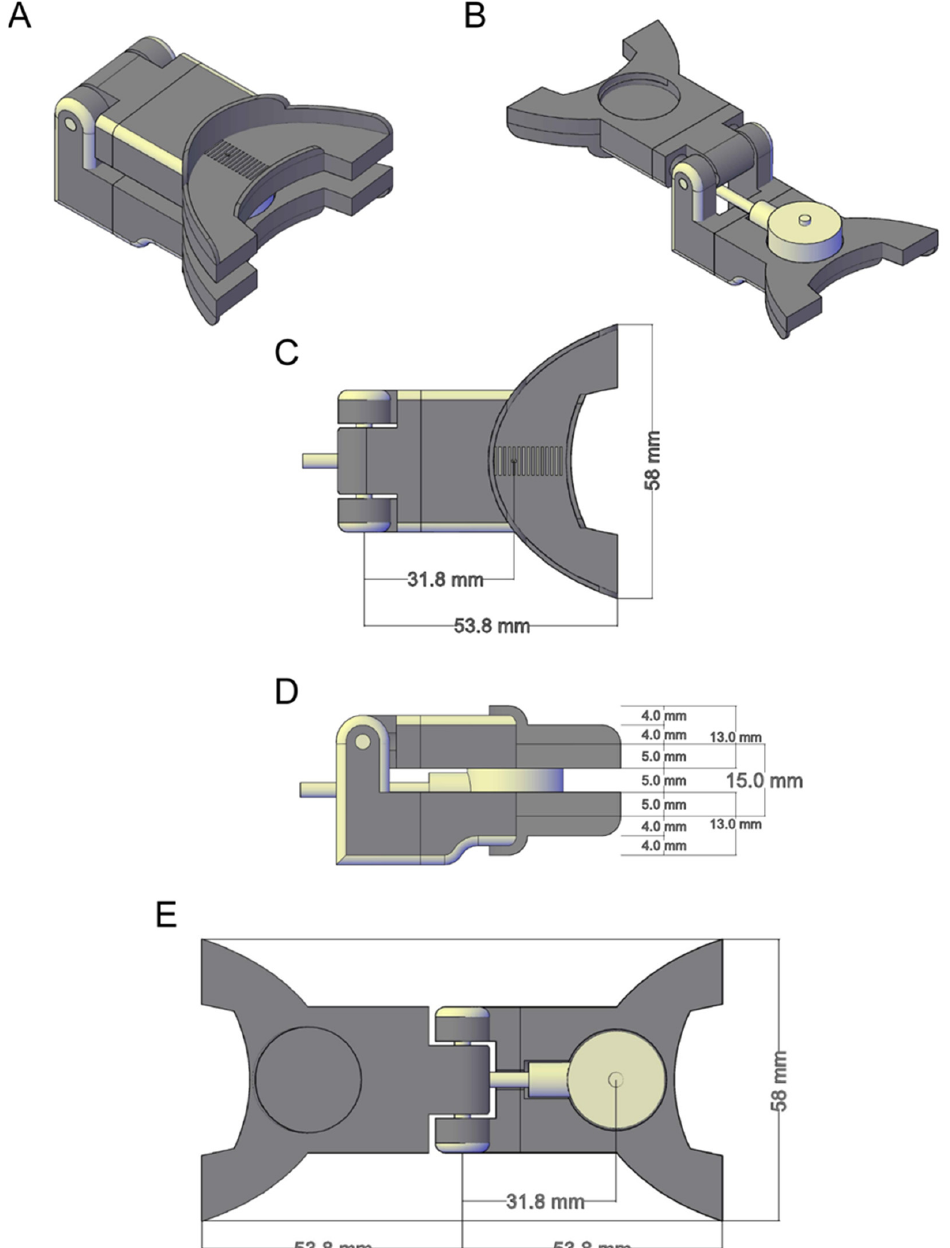
Figure 2. Interface of 3D CAD model. Representation of the 3D printed interface and the force measurement sensor CAD models. ( A , B ) Isometric view of the 3D sensor placed in the interface CAD while the upper fork plate is closed ( A ) and open ( B ). ( C , D ) The top-bottom and medio-lateral views of the sensor-interface CAD with the relative sizes, respectively. ( E ) Top-bottom view of the sensor while the upper fork plate is open.